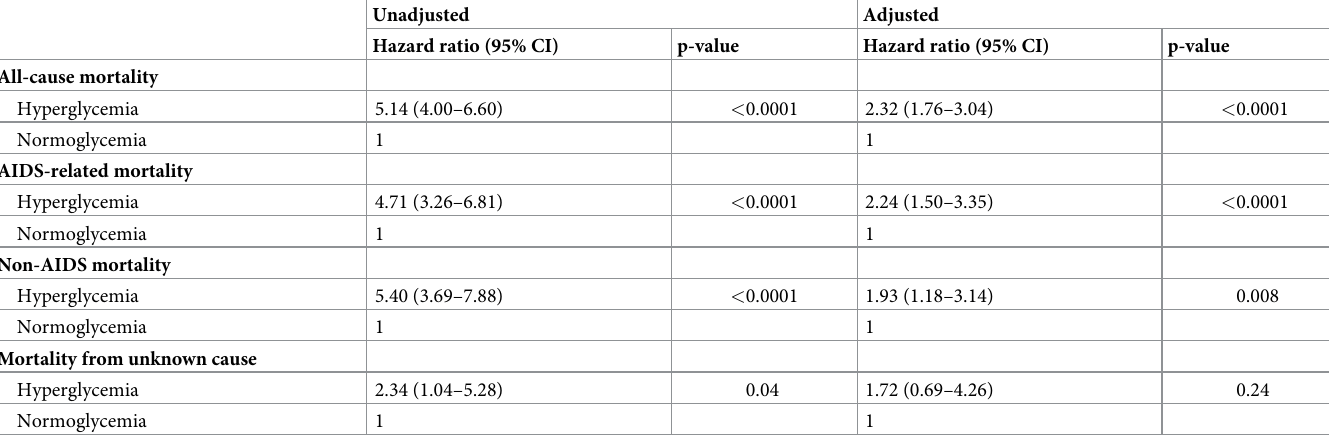
Table 2. Multivariate analysis of the association of hyperglycemia with all-cause and cause-specific mortality (n = 2914).